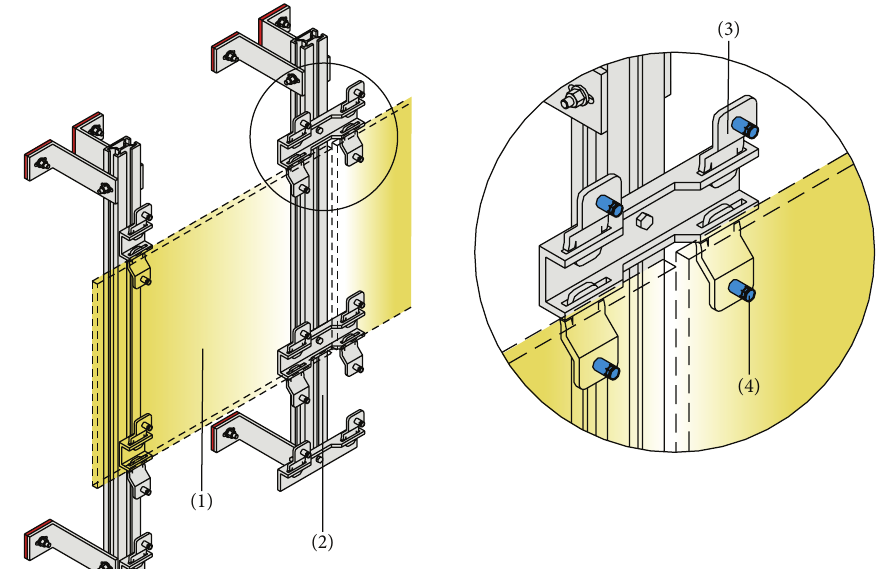
Figure1:Exampleofunderstructureforfixingventilatedfacadecladdings.Designations:(1)facadepanel,(2)steel-aluminumunderstructure, (3) holder fixing the facade panel, and (4) undercut fixing.